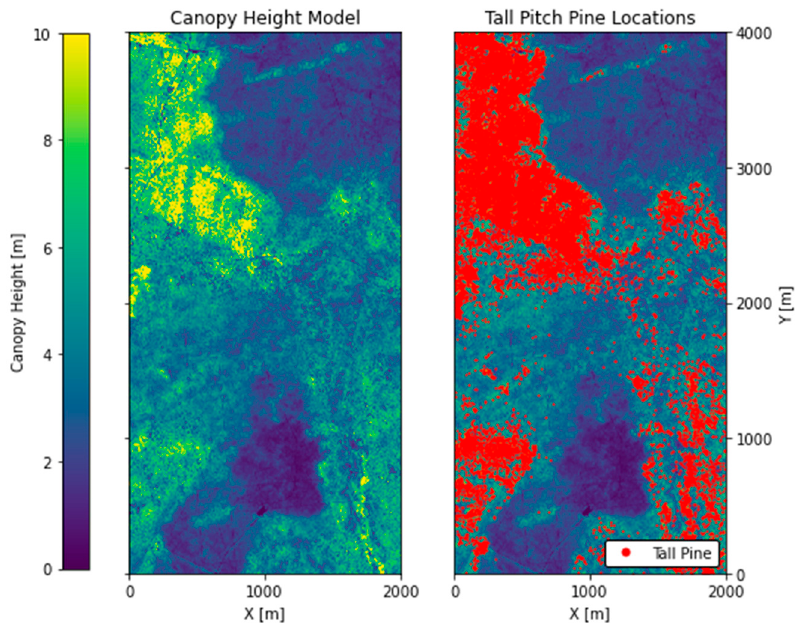
Table 1. Attributes for dwarf pitch pine, typical pitch pine, and oak used in the Spring Hill Fire reconstruction.